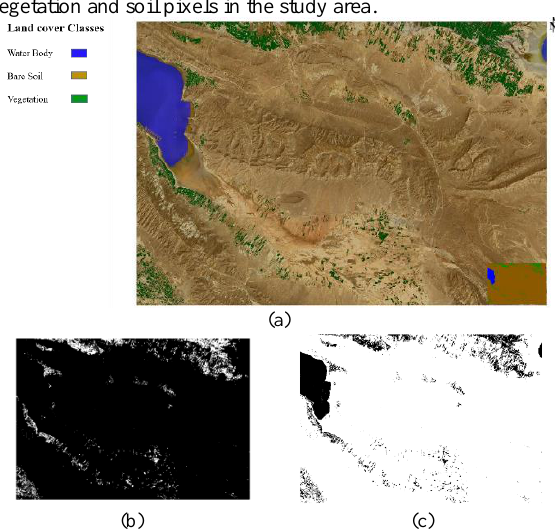
(c) Figure 3. The distinction of different land cover types pixels based on the results of the classification: (a) maximum likelihood classification results with three classes, (b) vegetation mask pixels (black: non-veg., white: veg.), and (c) soil mask pixels (black: non- soil, white: soil).